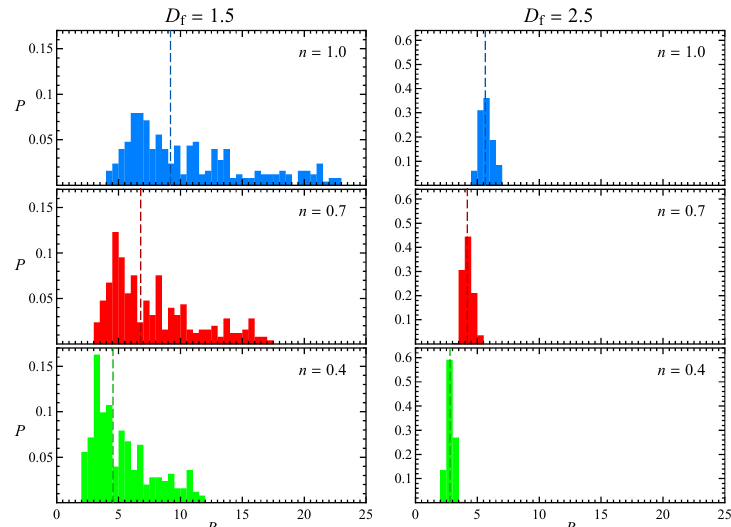
Figure 2. Probability distribution of the intrinsic viscosity corresponding to the initial aggregate orientations used to build the look-up table, for low ( left ) and high ( right ) fractal dimension and three flow indexes. The dashed line represents the median of the distribution.